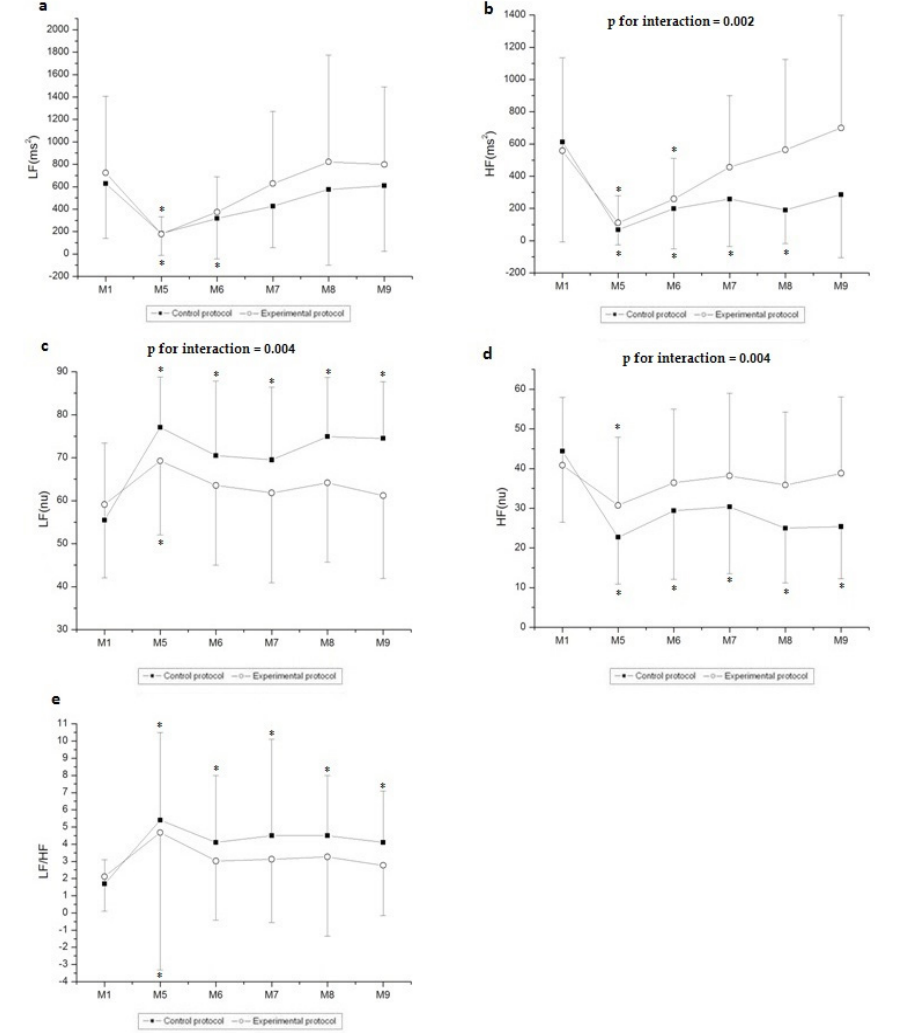
Figure 5. Values are mean ± standard deviation. ( a ) LFms 2 , ( b ) HFms 2 , ( c ) LFnu, ( d ) HFnu, and( e ) LF/HF during recovery and the comparison in control and experimental protocols. Final 5 minutes of rest (M1) and minutes of recovery: 5–10 (M5), 15–20 (M6), 25–30 (M7), 40–45 (M8), 55–60 (M9). * Different from M1 ( p < 0.05); LF, low frequency; HF, high frequency; M, moment; ms, milliseconds; nu, normalized